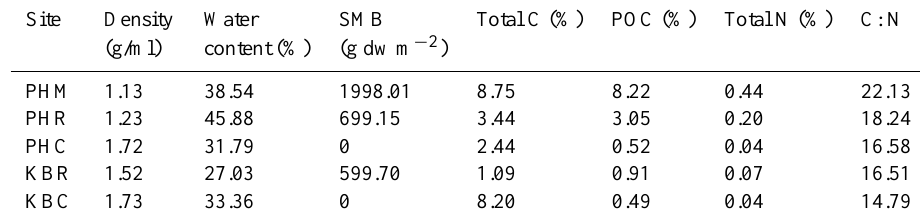
Table 1. Summary of sediment characteristics (averaged over top 5cm of sediment) from single un-amended cores collected at all 5 sites. Water content was determined by weight loss upon drying at 60 ◦ C and total C and N were measured by CHN analysis (Middelburg et al., 2000). POC was analyzed by CHN analysis following acidification to remove inorganic C as in Middelburg et al.